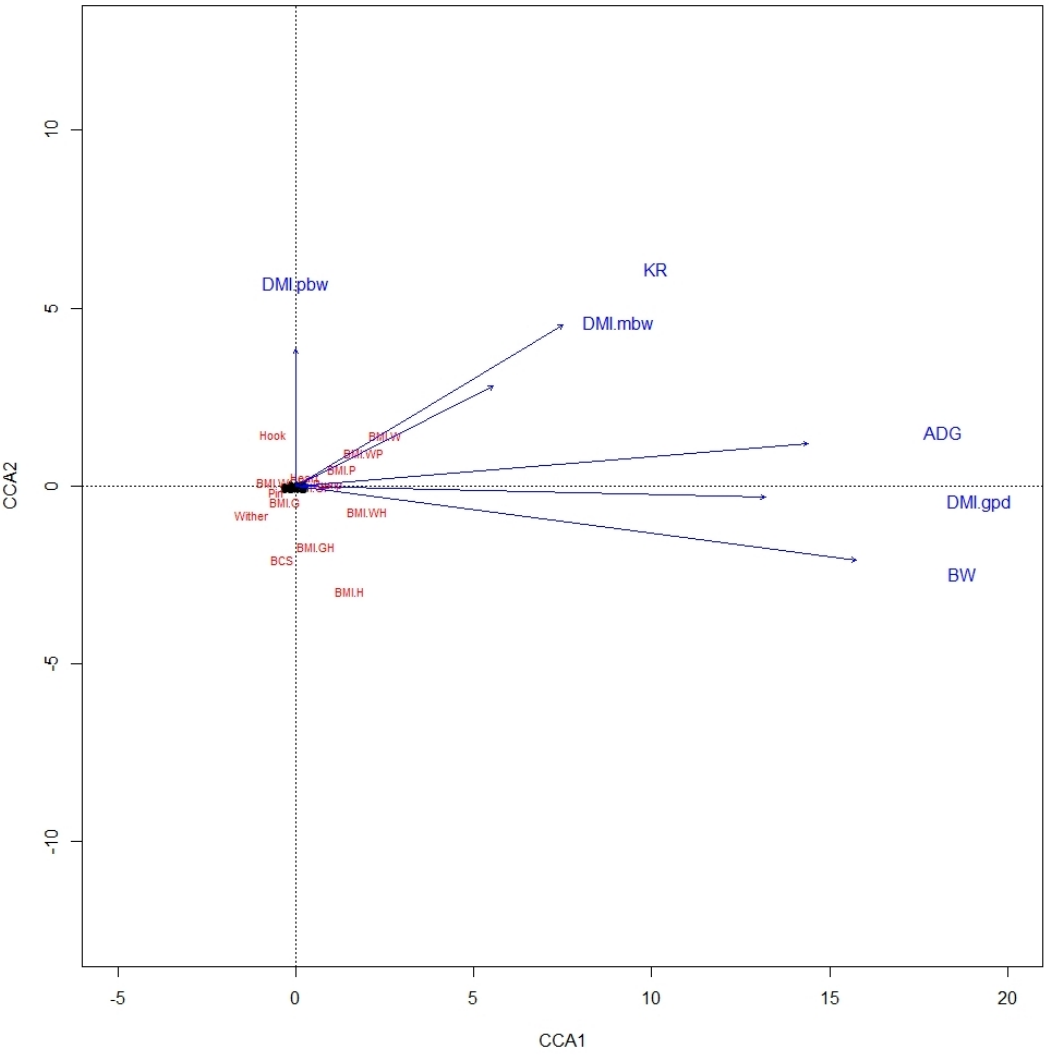
Figure 2. A canonical correspondence analysis (CCA) displaying the relationship between the linear body measures, body condition score, and body mass indexes and performance variables of Katahdin ewe lambs. Arrows show the direction of the gradient, with stronger relationships depicted by longer arrows. The abbreviations are defined in Figure 1.